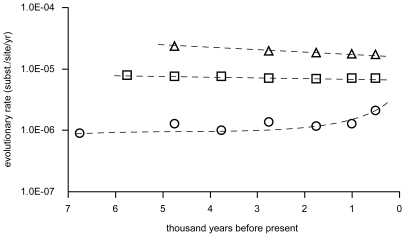
Accelerated rate of evolution in β-xylosidase.Estimates of evolutionary rates for the positively selected β-xylosidase (circles), cellulase (squares), and the non-coding “STS2” nucleotide sequence (triangles) in Mycosphaerella graminicola.